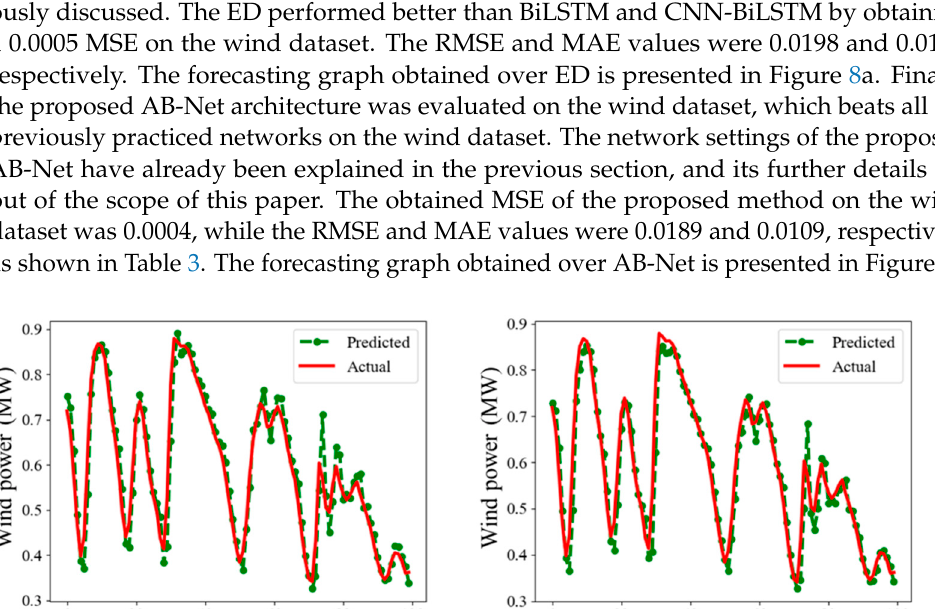
Table 3. Results obtained for different models on wind data via ablation study.